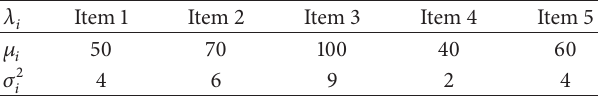
Table 1: Parameters of the random demand 𝐷 𝑖 .